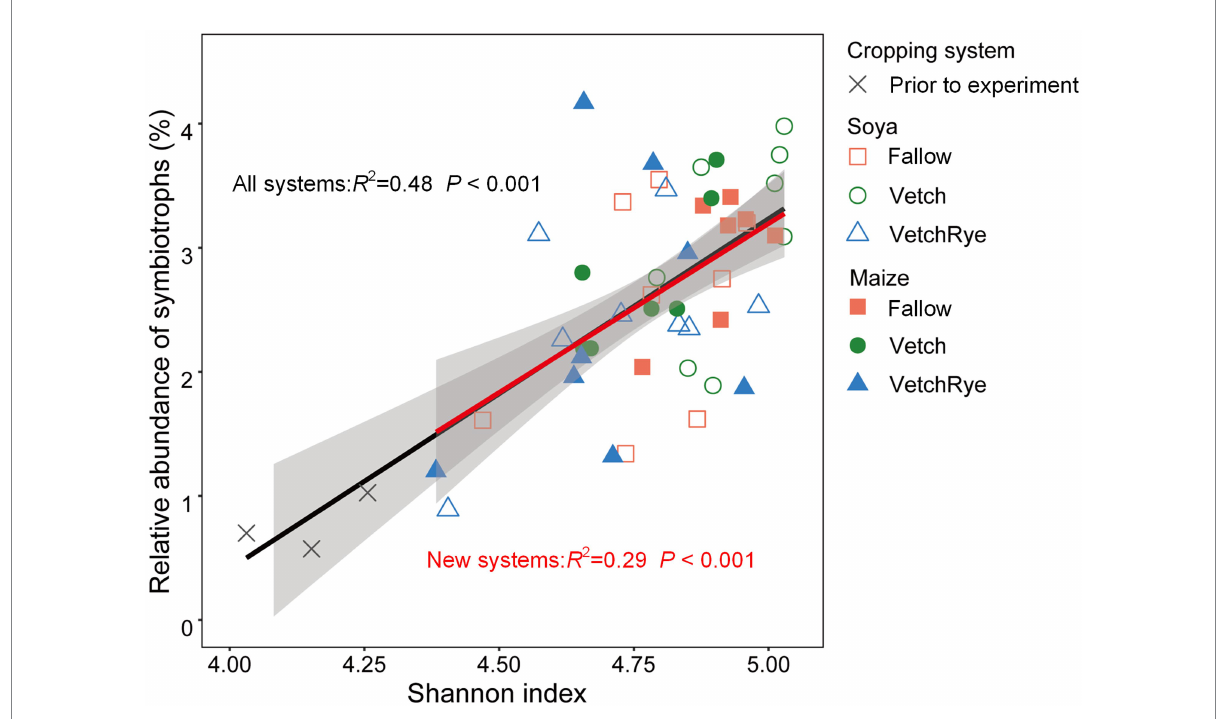
FIGURE 4 Correlations of the relative abundance of symbiotrophs with the Shannon